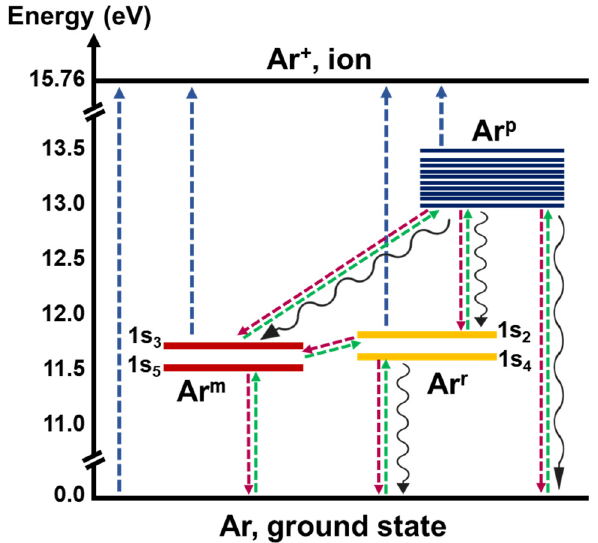
Figure 1. Diagram of energy levels and transitions of an argon atom. The arrows represent some reactions considered in the model. Blue arrows denote ionization of Ar ground state and excited species (reactions R2–R5), green arrows the excitations (reactions R6–R8, R12–R14), red arrows the deexcitations collisions (reactions R9–R11, R15–R17), and the black wavy arrows the radiative deexcitations (reactions R23–R26).